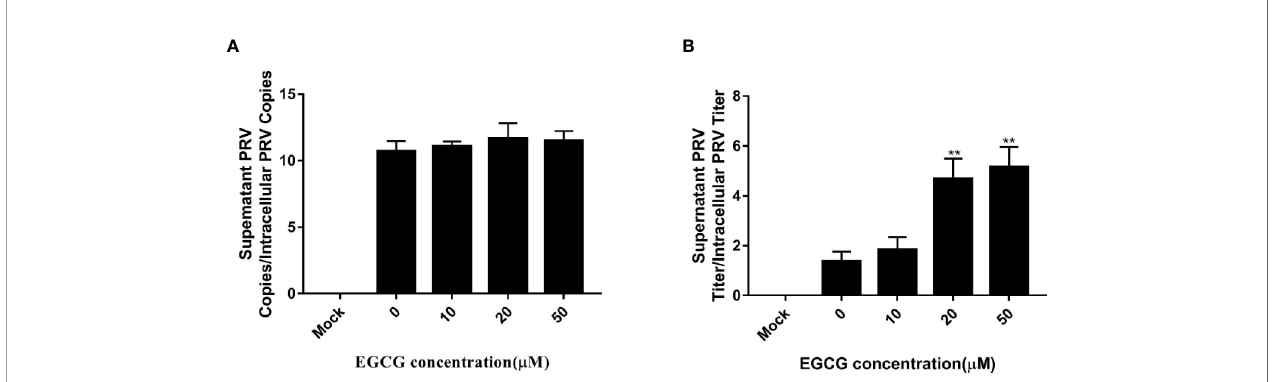
FIGURE 7 | Effect of ( – )-Epigallocatechin-3-gallate (EGCG) on pseudorabies virus (PRV) assembly and release. PK15 B6 cells were infected with PRV XJ5 (MOI=0.1) in 37°C for 1 h, then treated with 10, 20, 50, or 100 µM EGCG. (A) Supernatant and cells were harvested to determine PRV DNA copy numbers at 24 hpi and the ratio of extracellular to intracellular PRV DNA copies was calculated. (B) PRV viral titers in supernatant and cells were assayed at 24 hpi and the ratio of extracellular to intracellular PRV viral titers was calculated. **p < 0.01.